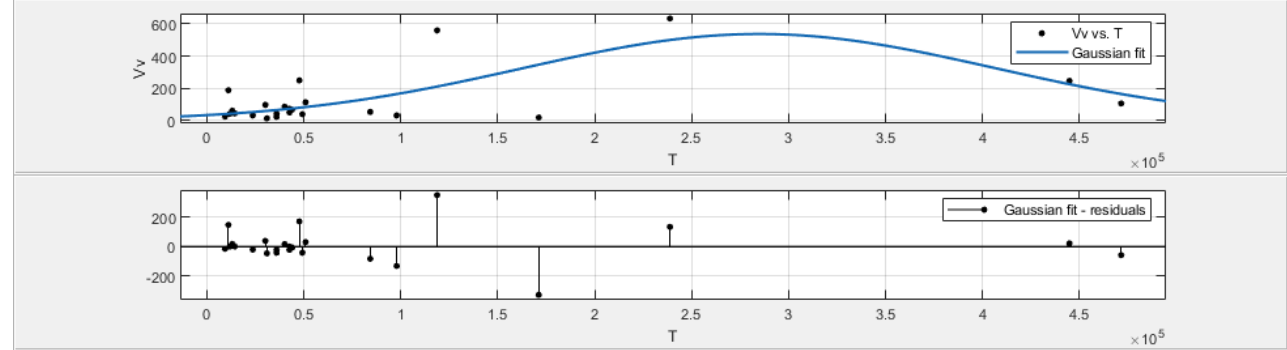
Figure 12. Gaussian Vv vs . T curve fitting with residuals. Table 2. Gaussian curve fitting model parameters for Vv vs. T .